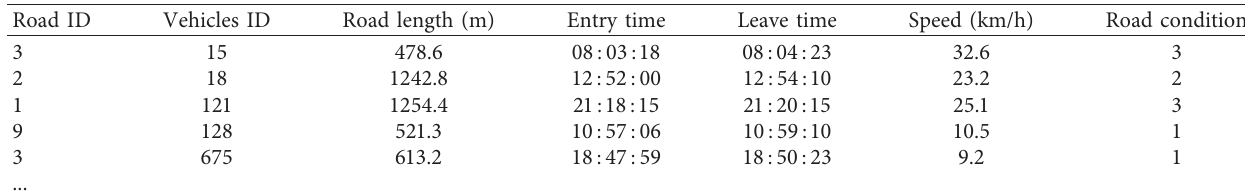
Table 1: Statistical table of road conditions of